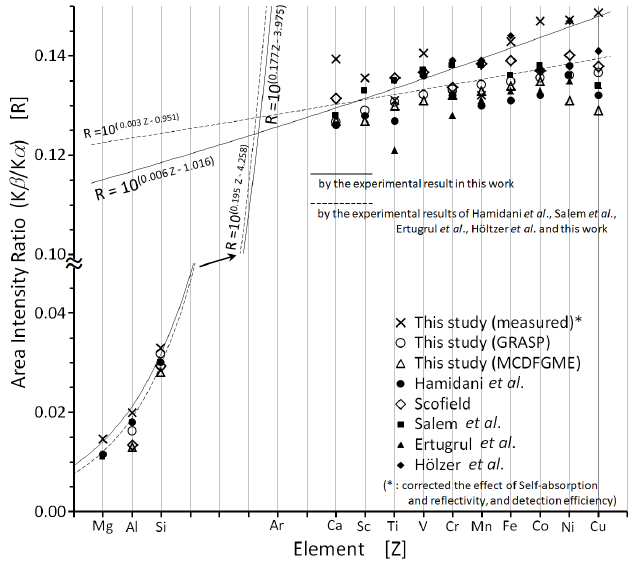
Figure 3. K β / K α intensity ratio from Mg to Cu together with other reported data–Hamidani et al. average [1], Scofield [3], Salem et al. [25], Ertugrul et al. [26], and Hölzer et al. [9]. See text for